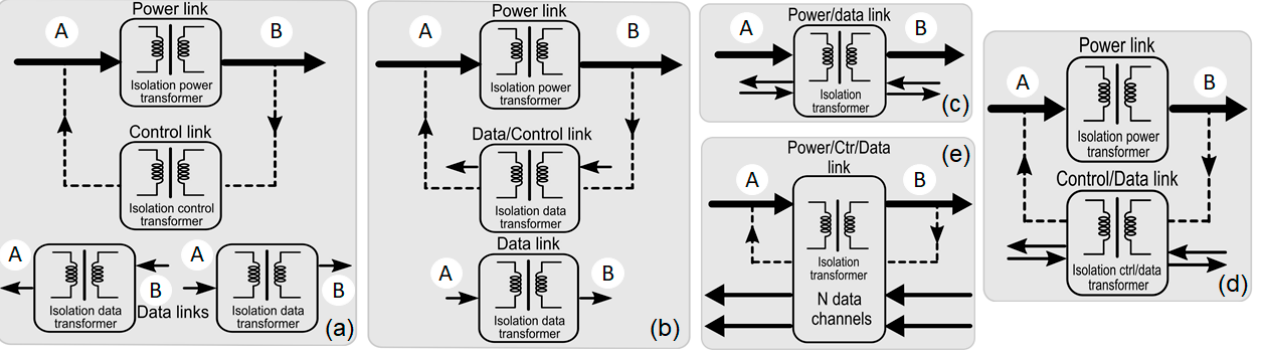
Figure 5. Architectures for galvanically isolated power/data transfer systems: ( a ) Traditional [19]. ( b ) In [20]. ( c ) In [21]. ( d ) In [22]. ( e ) In [23]. Reproduced from [17]. Copyright 2019, IEEE.